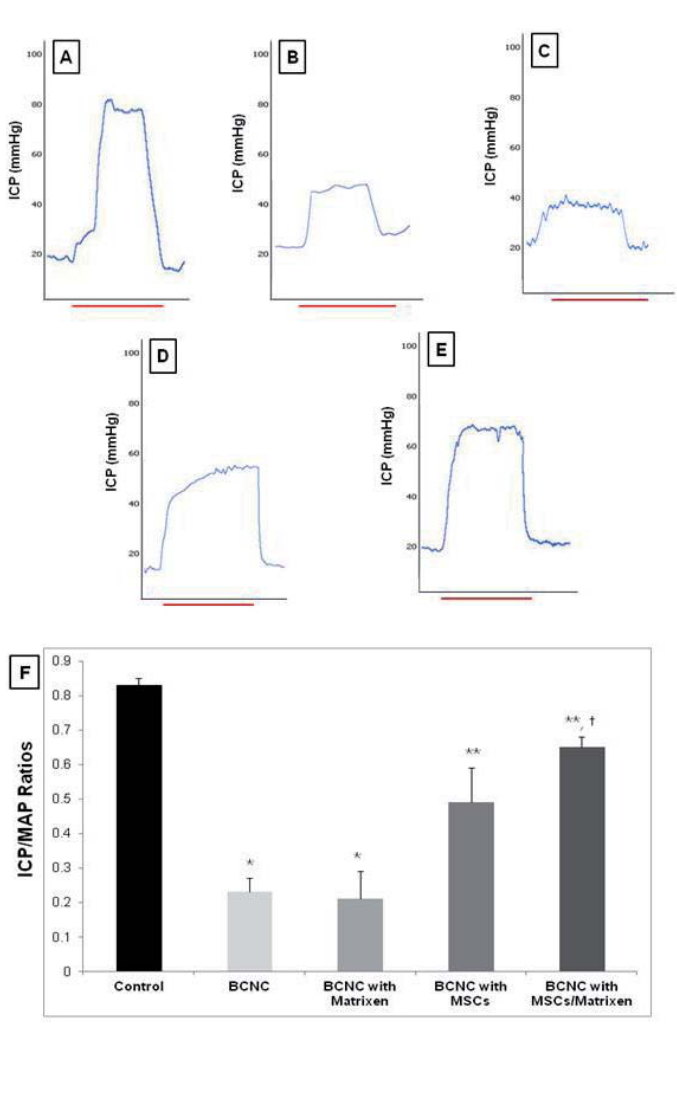
Figure 2 - Erectile functional assessment under cavernous nerve stimulation (CNS) at week 4 in control (A); bilateral cavernous nerve (BCNC) crushing (B); BCNC with Matrixen (C); BCNC with mesenchymal stem cells (MSCs) (D); BCNC with MSCs mixed with Matrixen group (E). The voltage dependent erectile response to CNS represented by the ratios of intracavernous pressure (ICP) / mean arterial pressure (MAP) (F). *P < 0.05 compared with the control group, **P < 0.05 compared with BCNC group, †P < 0.05 compared with BCNC injected with MSCs